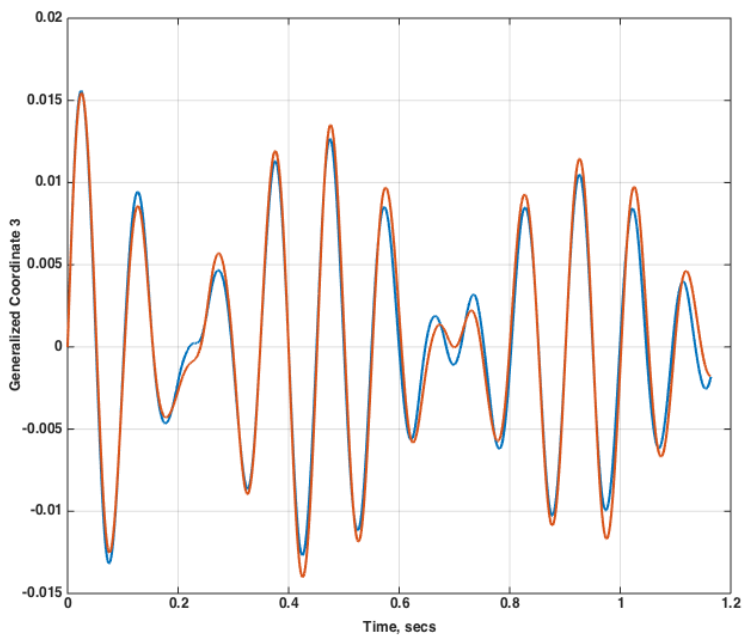
Figure 14. Aeroelastic response in mode 3 for the FUN3D (blue) and ROM (orange) solutions for the configuration including the Transonic Dynamics Tunnel (TDT).